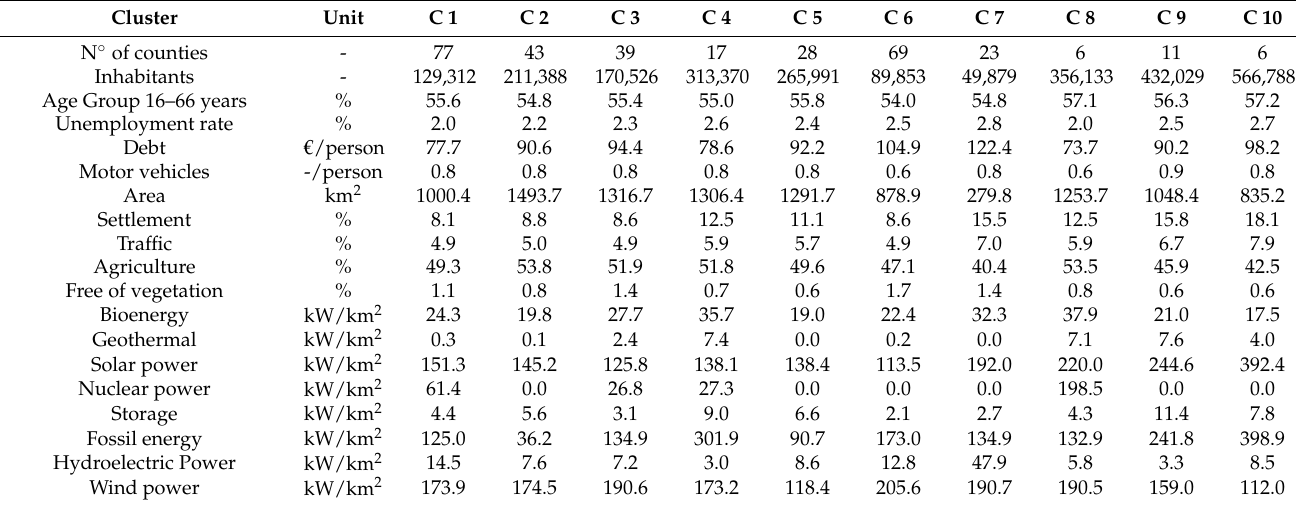
Table 7. Characteristics of identified